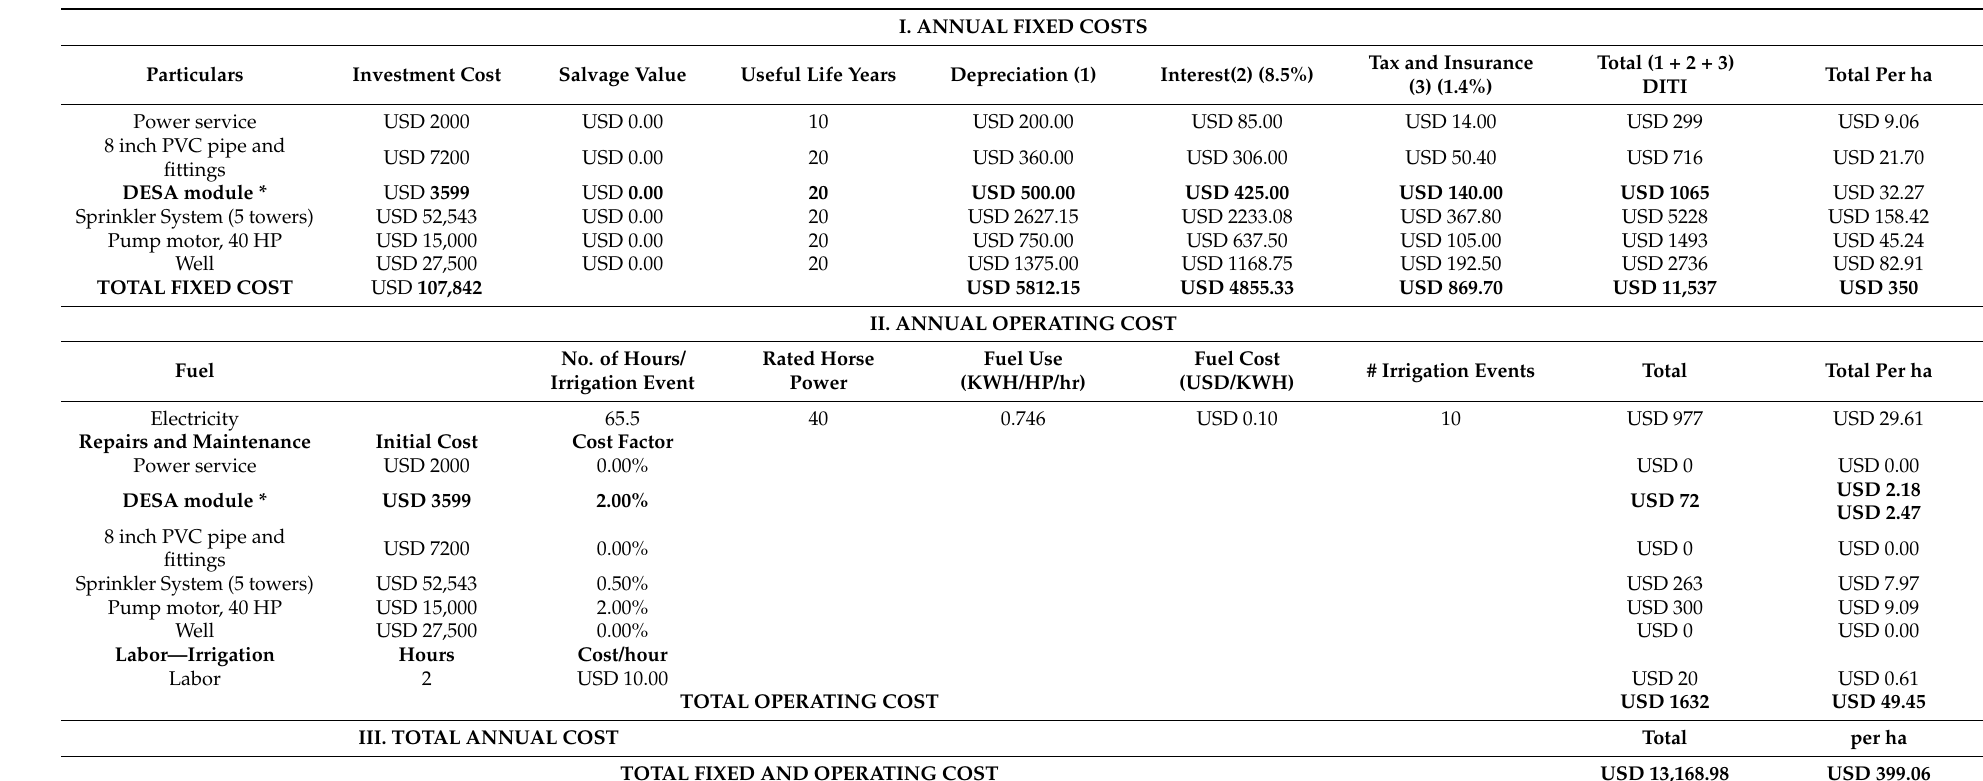
Table 10. Economic analysis of a CPD-based irrigation system featured with the sensor